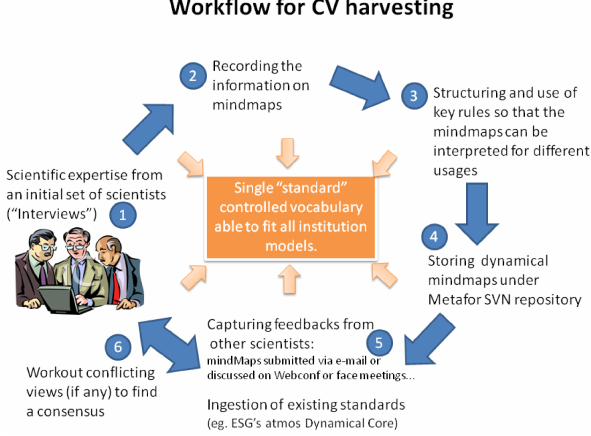
Fig. 1. Consultation process with scientists to define the CV for climate model description.